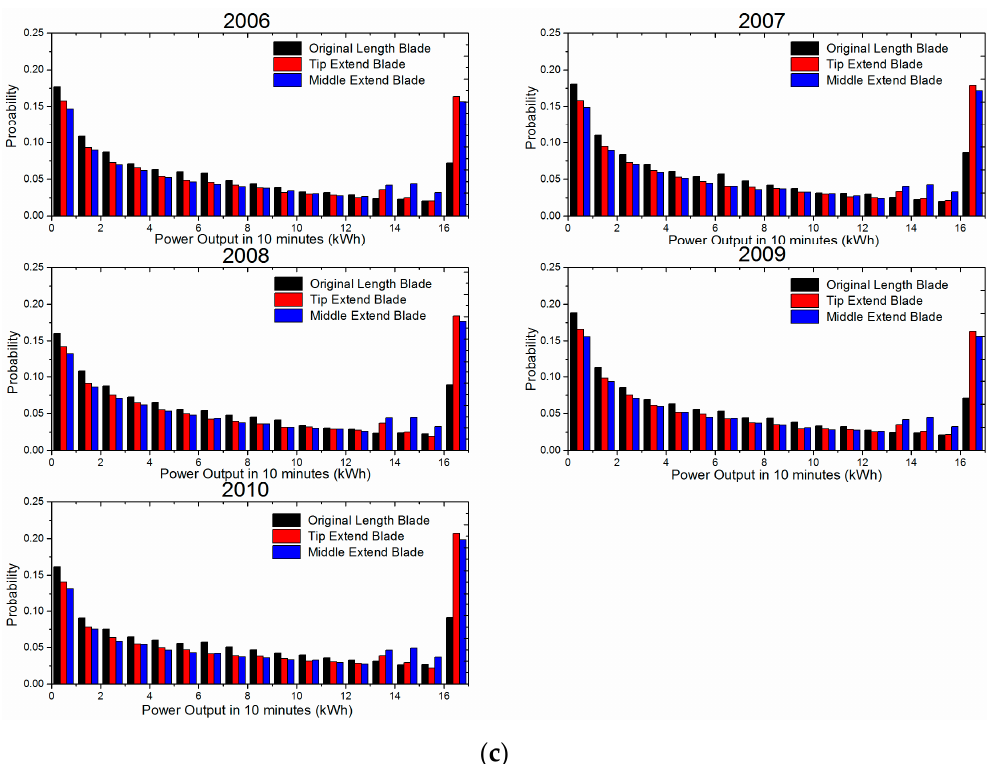
Figure 11. Statistical distribution of 10 min of energy output for the original blade and extensible blades at ( a ) Site A; ( b ) Site B; ( c ) Site C.